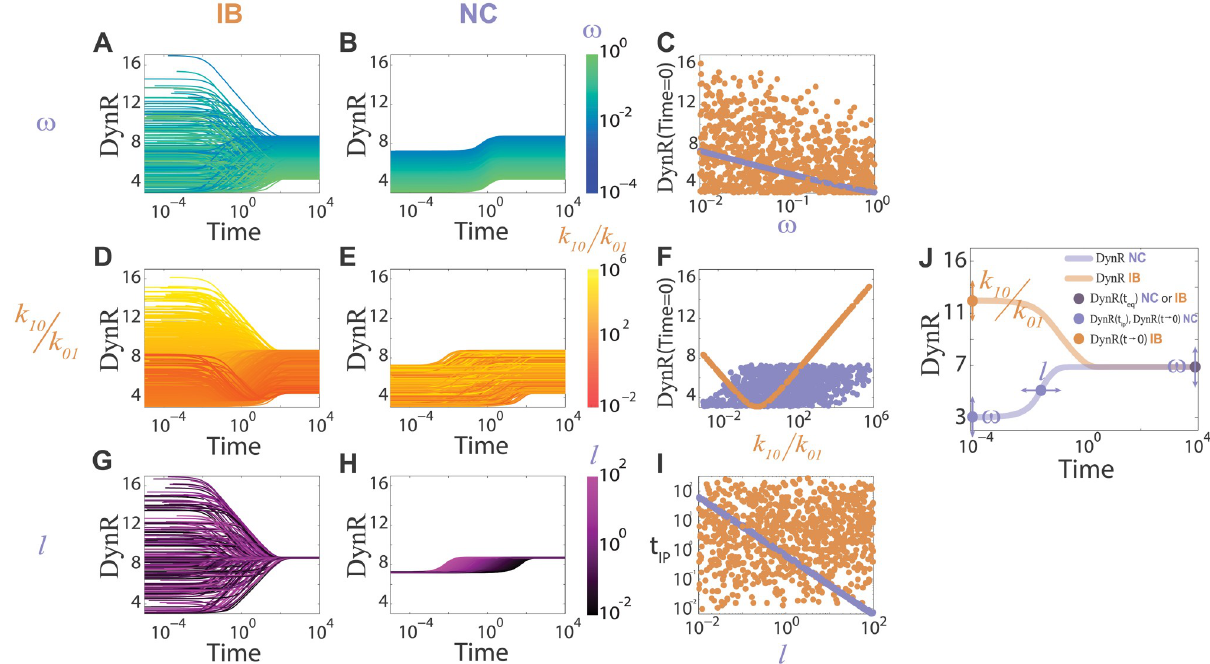
Fig 3. The dose-response curve evolves in time differently for IB and NC models. The plots DynR versus time (panels (A), (B), (D), (E), (G), (H)) were computed from 10000 parameter sets chosen randomly in the non-identifiability manifold, as explained in the Methods section. For t > 10 3 all the curves are in equilibrium, which is the same for both models; for t < 10 − 3 all the curves are in pre-equilibrium. Panels (A), (D), (G) come from the IB model; panels (B), (E), (H) come from the NC model. In different panels different parameters are coded in a color scale: ω in (A) and (B), k 10 / k 01 in (D) and (E), and l in (G) and (H), we call them control parameters, they control the pre-equilibrium properties of the DynR versus time curves. Only in panels (D) and (E), and (C), (F), (I) the complete databases with 10000 sets are included. For clarity, panels (A) and (B) contain only curves with 0.9 < l < 1.1 (207 curves), and panels (G) and (H) contain only curves with 0.010 < ω < 0.011 (218 curves). Complete databases are included in S1 Text (Fig D in S1 Text). (C). DynR (t ! 0) versus ω . (F). DynR (t ! 0) versus k 10 / k 01 . (I). t ip (time at which the inflection point in DynR versus time occurs) versus l . In panels (C), (F), (I), brown dots for IB , indigo dots for NC . (J). Summary of how each of the considered parameters ( ω , k 10 / k 01 , and l ) control different properties of the curve DynR versus time: ω controls DynR (t ! 0) in NC model and DynR (t ! 1 ) in both models, k 10 / k 01 controls DynR (t ! 0) in IB model, and l controls the time where the curve DynR versus time has an inflection point in NC model.